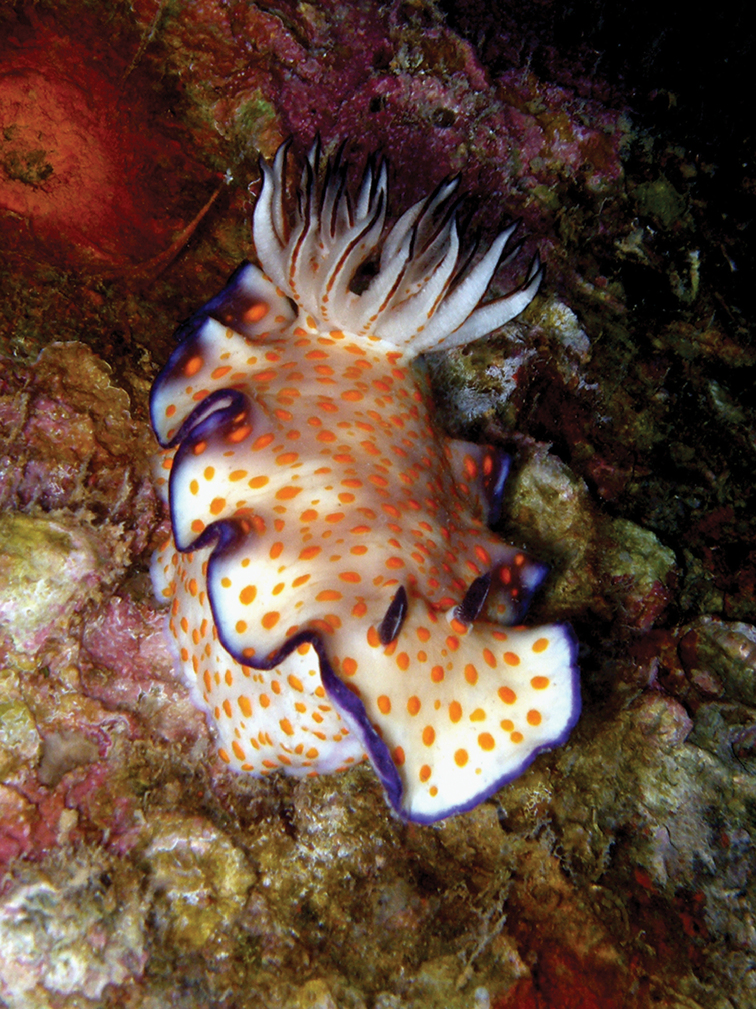

Risbecia
pulchella (Rüppell & Leuckart, 1830), photograph S Kahlbrock.